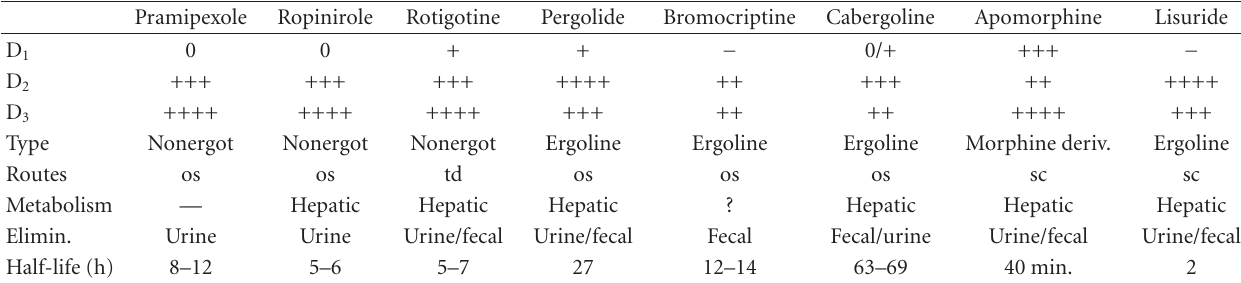
Table 1: Pharmacological characteristics of dopamine